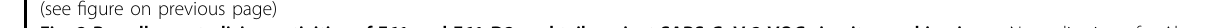
Fig. 2 Broadly neutralizing activities of F61 and F61-D2 cocktail against SARS-CoV-2 VOCs in vitro and in vivo. a Neutralization of mAbs to SARS-CoV-2 pseudovirus in HEK293T-hACE2 cells. Data were obtained from a representative neutralization experiment, which contains two replicates. Data are represented as means ± SD (upper panel) and means (down panel). The pseudovirus neutralization assay was repeated at least three times in independent experiments. Results were highly consistent and therefore the data from one experiment were shown. b Neutralization of mAbs to SARS-CoV-2 authentic virus in Vero E6 cells. The authentic virus neutralization was repeated at least three times in independent experiments. Results were highly consistent and therefore the data from one experiment were showed. c Prophylactic effects of F61, D2 or F61-D2 cocktail against SARS- CoV-2 Omicron BA.1 and Delta variants in K18-hACE2 mice. Body weights change (%), survival curves, and viral RNA loads in the lungs of K18-hACE2 mice treated with difference doses of antibodies (1.25, 2.5, 5, 20 mg/kg) F61, D2, or F61 + D2 via intranasal route before infection with 100 TCID 50 / mouse Delta variant (upper panel) or 200 TCID 50 /mouse Omicron BA.1 variant (down panel). As a negative control, PBS was administered. Body weight curve values represent means ± SD ( n = 4 – 6 mice/group). Signi fi cant differences between the antibody treatment group and negative control are shown. All data points for viral load in the lungs are shown, along with the medians. ns, P > 0.05; * P < 0.05; ** P < 0.0001, as determined by One-way ANONA. Limit of detection (LOD), 500